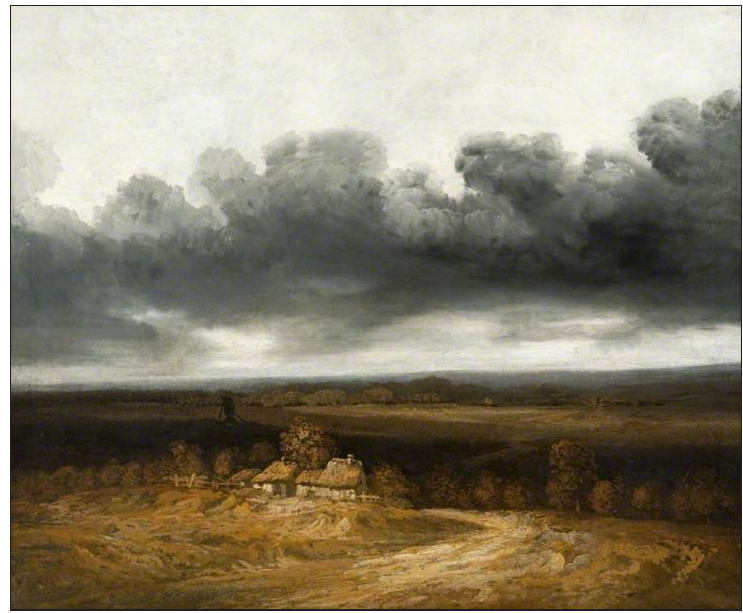
Fig. 4 : Georges Michel, Landscape with Cottages , after 1830, oil on canvas, 78.5 × 99.2 cm, Kelvingrove Art Gallery and Museum. Art UK. Photo credit: Glasgow